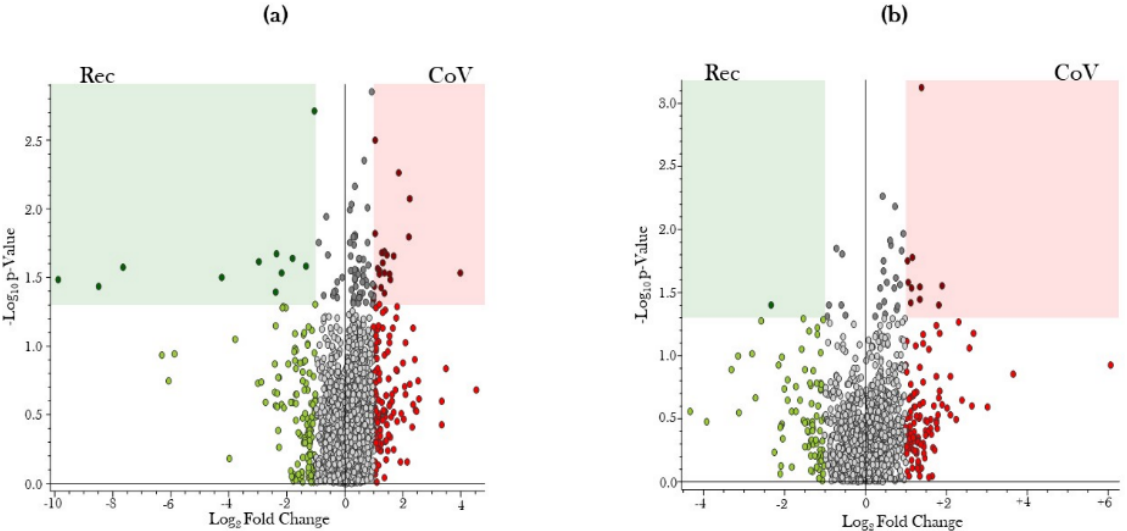
Figure 3. Volcano plot showing number and distribution of serum metabolites in COVID-19-positive and COVID-19-recovered patients. Serum samples from COVID-19-positive (CoV) and COVID-19-recovered (Rec) patients were obtained, and the serum metabolites were quantitated using ultra-performance liquid chromatography–mass spectrometry (UPLC- MS). The differential expression of serum metabolites among CoV and Rec patients was represented as a volcano plot of –log10 ( p -value) (Y-axis) versus log2 (Fold Change) (X-axis) for ( a ) positive and ( b ) negative ion modes of UPLC-MS